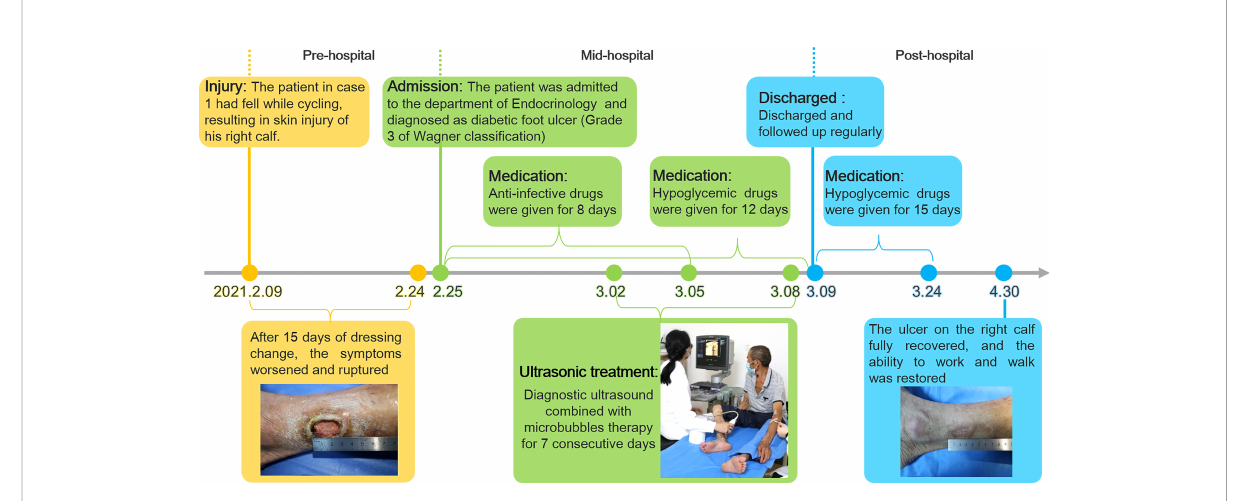
FIGURE 3 The timeline of the treatment process of case 1 from the day of injury to the day of